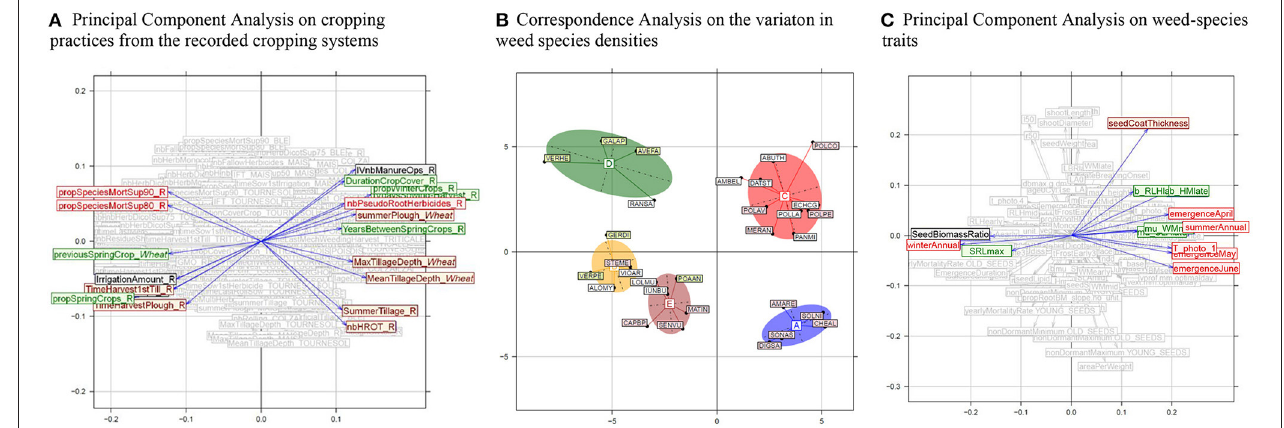
FIGURE 5 | The weed species (named with EPPO codes) and species traits that are selected when tillage is deleted from recorded cropping systems without compensating practices, depending on the characteristics of the recorded systems. Synthetic representation of the RLQ results with cropping techniques of the recorded cropping systems as matrix R, differences in weed plant densities in tillage-free vs. recorded systems as matrix L, and FLORSYS species parameters as matrix Q. (A) The cropping practices (list in Table A2 ) of the recorded cropping systems, with the most correlated to the difference in weed densities highlighted in blue based on fourth-corner analysis (green: rotation, brown: tillage, red: herbicides, black: others). (B) Weed species (list in Table A1 ), clustered into groups, following a Ward ascendant hierarchy classification, based on the difference in tillage-free vs. recorded systems; species labels are colored in red or green if their densities increased or decreased in the majority of situations when tillage was deleted (based on Figure 4 ). (C) Species parameters (list in Table A3 ), with the most correlated ones shown in blue (green: morphology and shading response, red: seasonality, brown: seed traits, black: others), based on fourth-corner analysis. Hidden